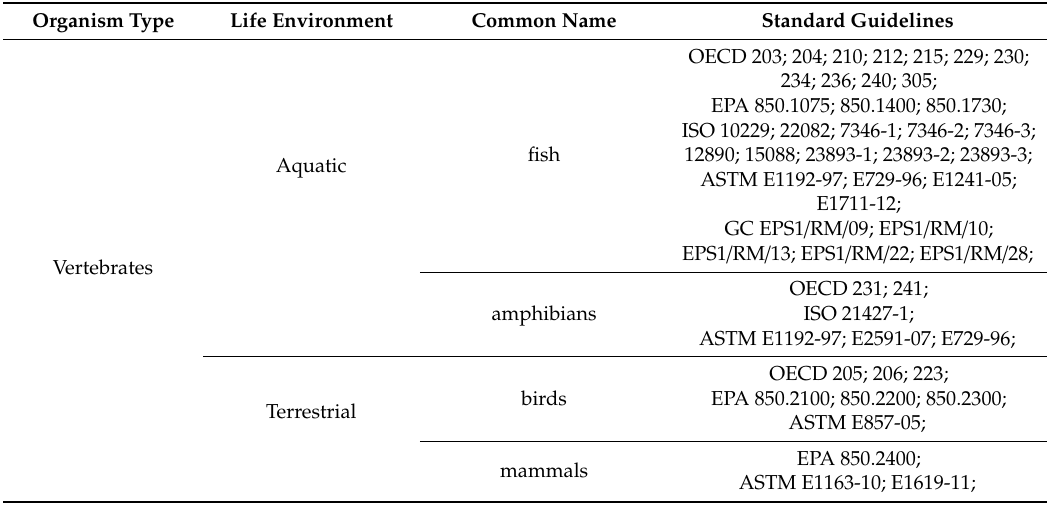
Table 3. Vertebrates used in standard ecotoxicity assays.